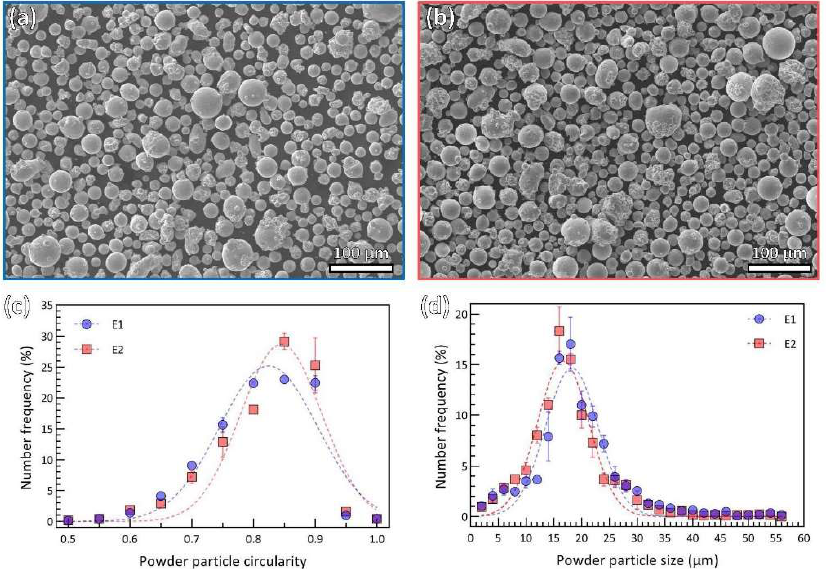
Figure 2. SEM micrographs showing the overview of powder particles ( a ) virgin powder (E1) and ( b ) reused powder (E2); powder particle size and shape distribution profile with number frequency as a function of powder particle size ( c ) and number frequency as a function of powder particle circularity ( d ) (dashed curves fitted by Gaussian distribution).